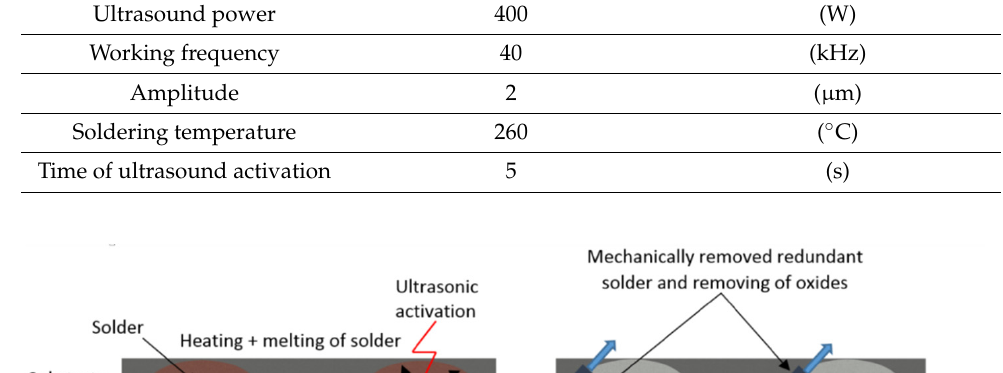
Figure 4. Table 2. Ultrasonic soldering parameters. Table 2. Ultrasonic soldering parameters.